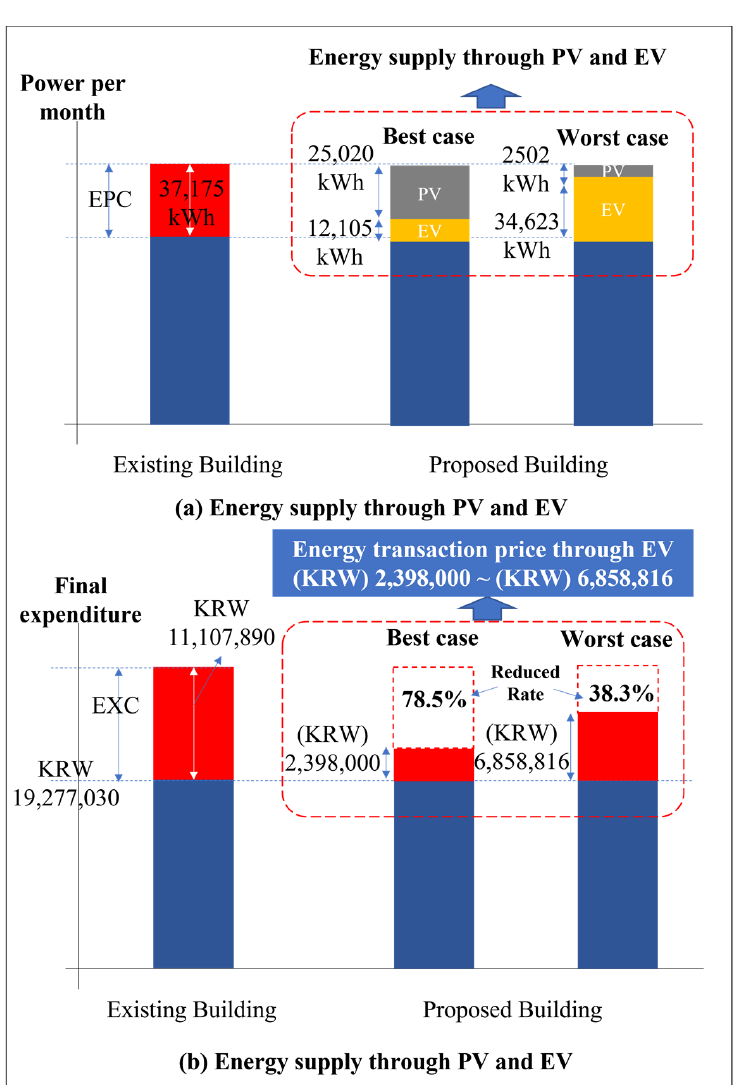
Figure 18. Existing building electricity bill by day and month.